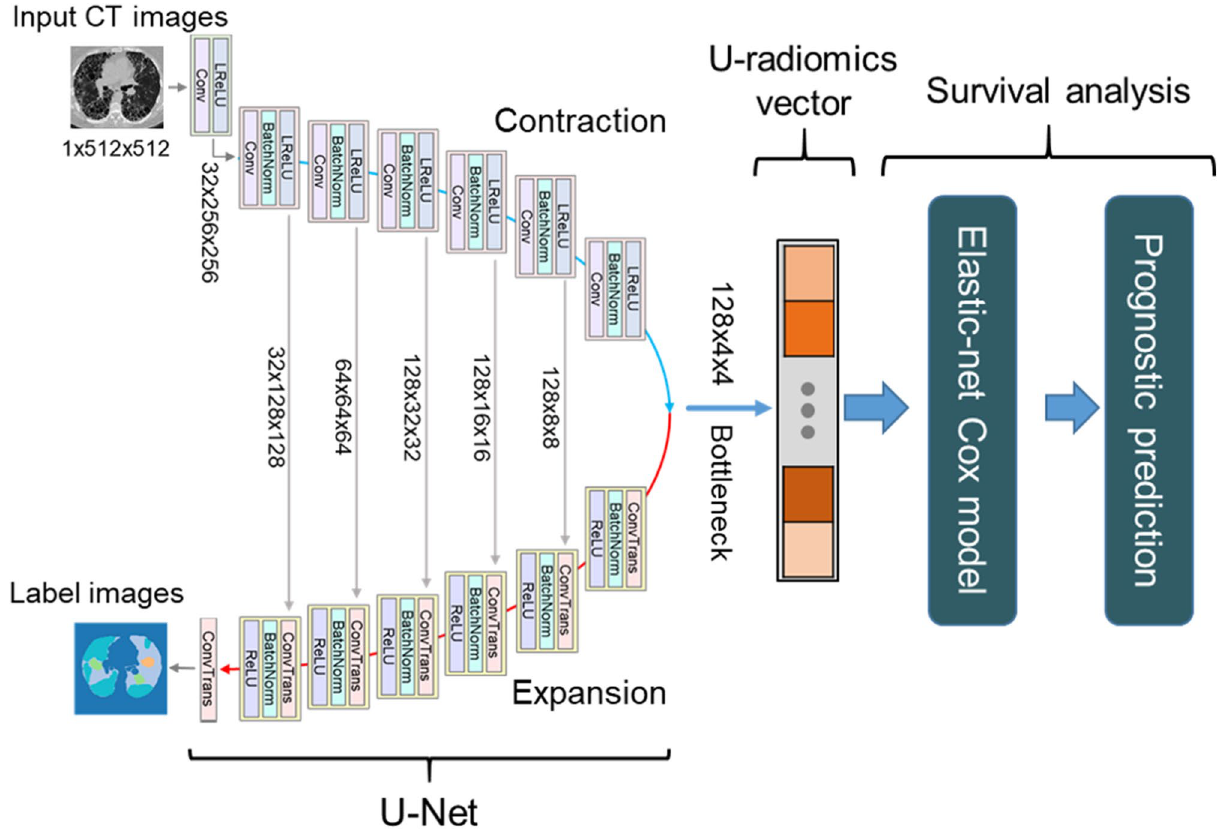
Figure 5. Schematic diagram of the U-survival model. The U-radiomics vector derived from the bottleneck section of the U-Net is subjected to an elastic-net Cox model for predicting the disease progression and mortality of a patient. Conv convolutional layer (kernel 4, stride: 2), ConvTrans transposed convolution (kernel 4, stride: 2), LReLU leaky rectified linear unit, BatchNorm batch